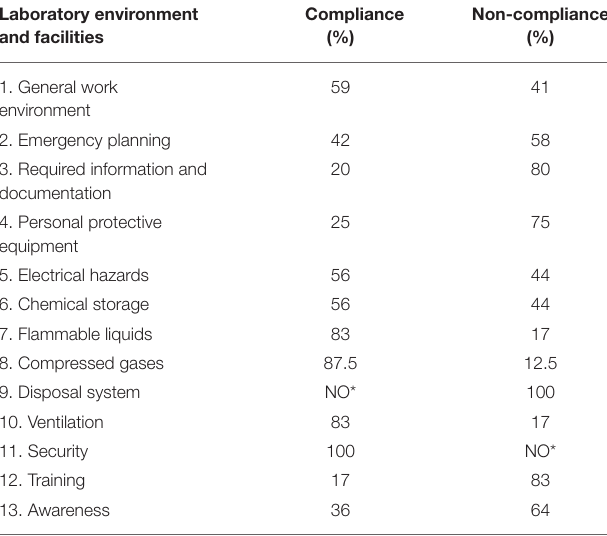
TABLE 2 | Results of hazard analysis checklist based on work processes and behaviors evaluated in university chemical laboratories and verified frequency of compliance and non-compliance with health, safety, and environmental